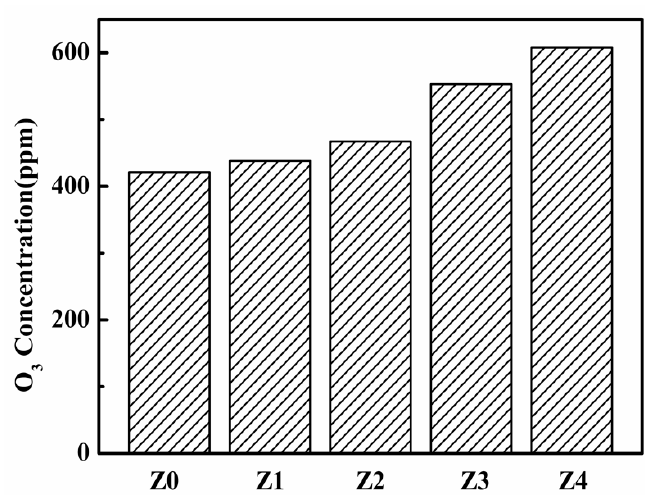
Figure 7. Ozone concentrations of the prepared catalysts.